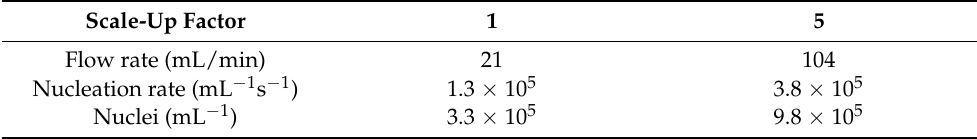
Table 4. Scale-up experiments at a constant ultrasonic power/volume and residence